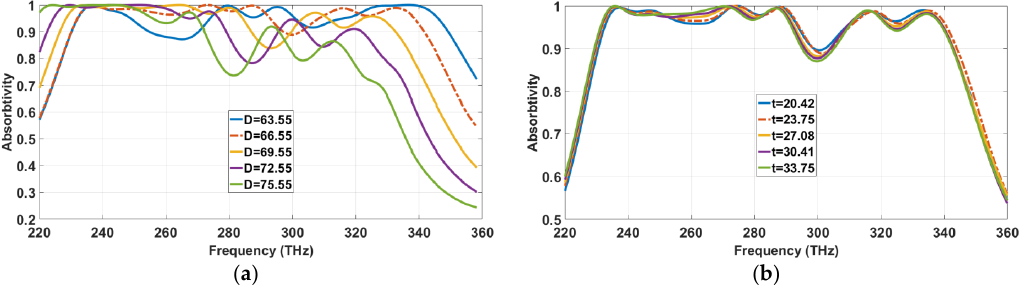
Figure 7. Absorption characteristics of proposed MA for different thicknesses of ( a ) dielectric substrate (D) and ( b ) metallic copper resonator